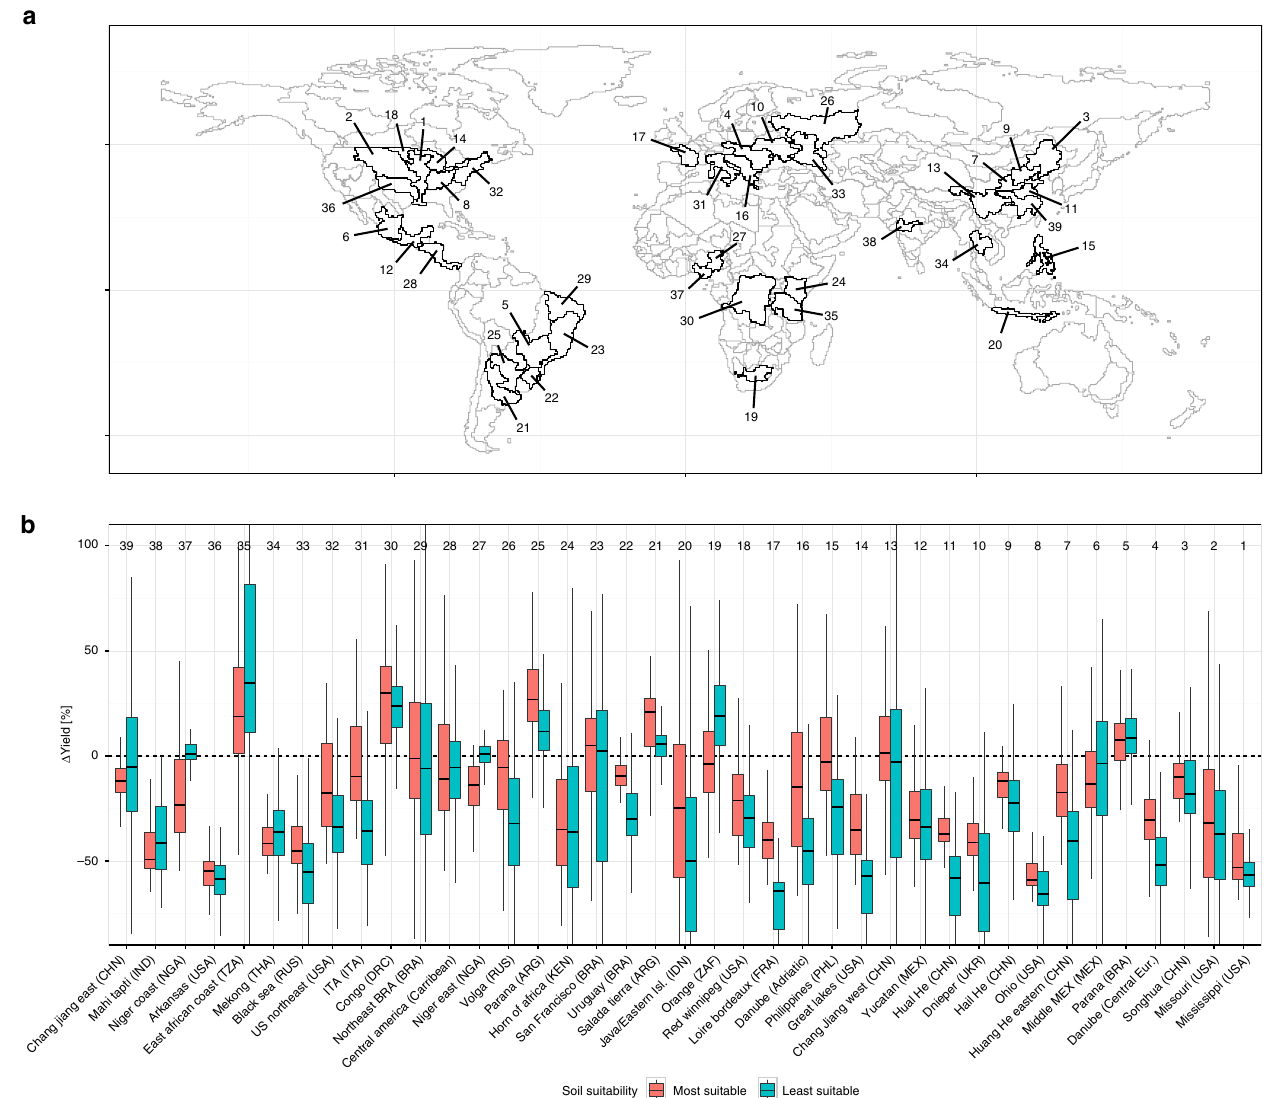
Figure 5 | Projected percentage change in maize yields by the 2050s in the 39 largest food production units (FPUs). ( a ) FPUs as defined by intersecting water basins with major administrative boundaries 53 . ( b ) Relative change in maize yields for the presently most or least suitable soil type in each grid cell for the rainfed business-as-usual nutrient input scenario (bau-nut-rf; Table 3). The climate projection is based on HadGEM2-ES for RCP8.5 and is compared here with present-day climate data (see the Methods for details). Each of the selected FPUs comprises more than 10 6 ha of harvested maize area. Ranking in terms of decreasing cultivated maize area is indicated by the order from right (largest) to left